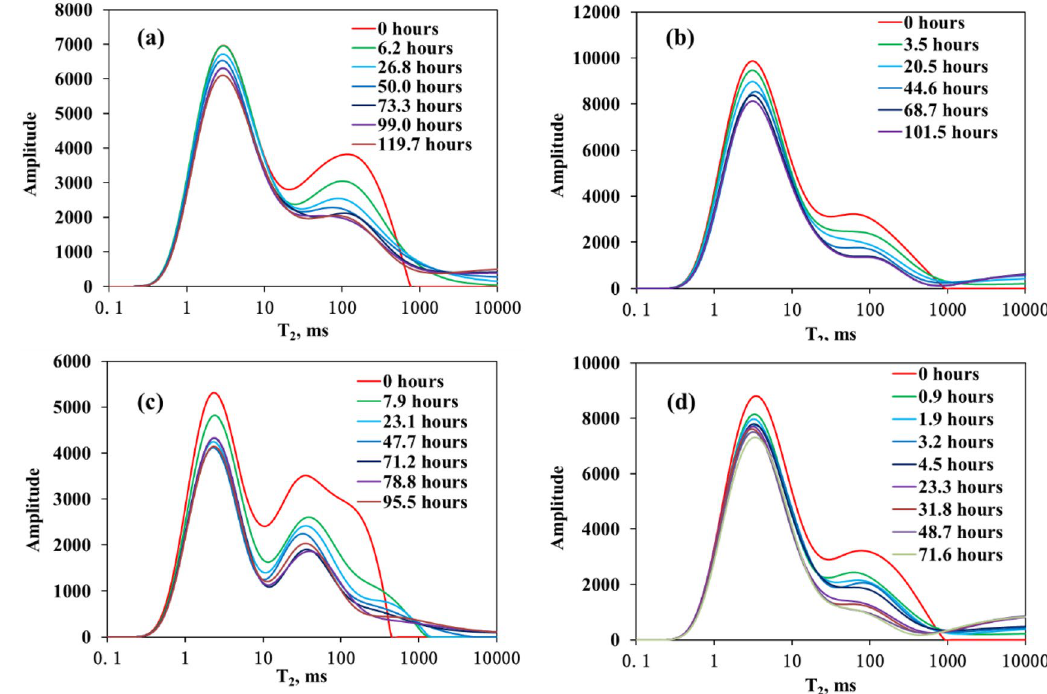
Figure 1. NMR T 2 spectra of CO 2 exposure experiments of the four cores: ( a ) 0.218 mD (sample 1#) without the fractures; ( b ) 0.598 mD (sample 2#) without the fractures; ( c ) 0.770 mD (sample 3#) without the fractures; ( d ) 0.598 mD (sample 4#) with the